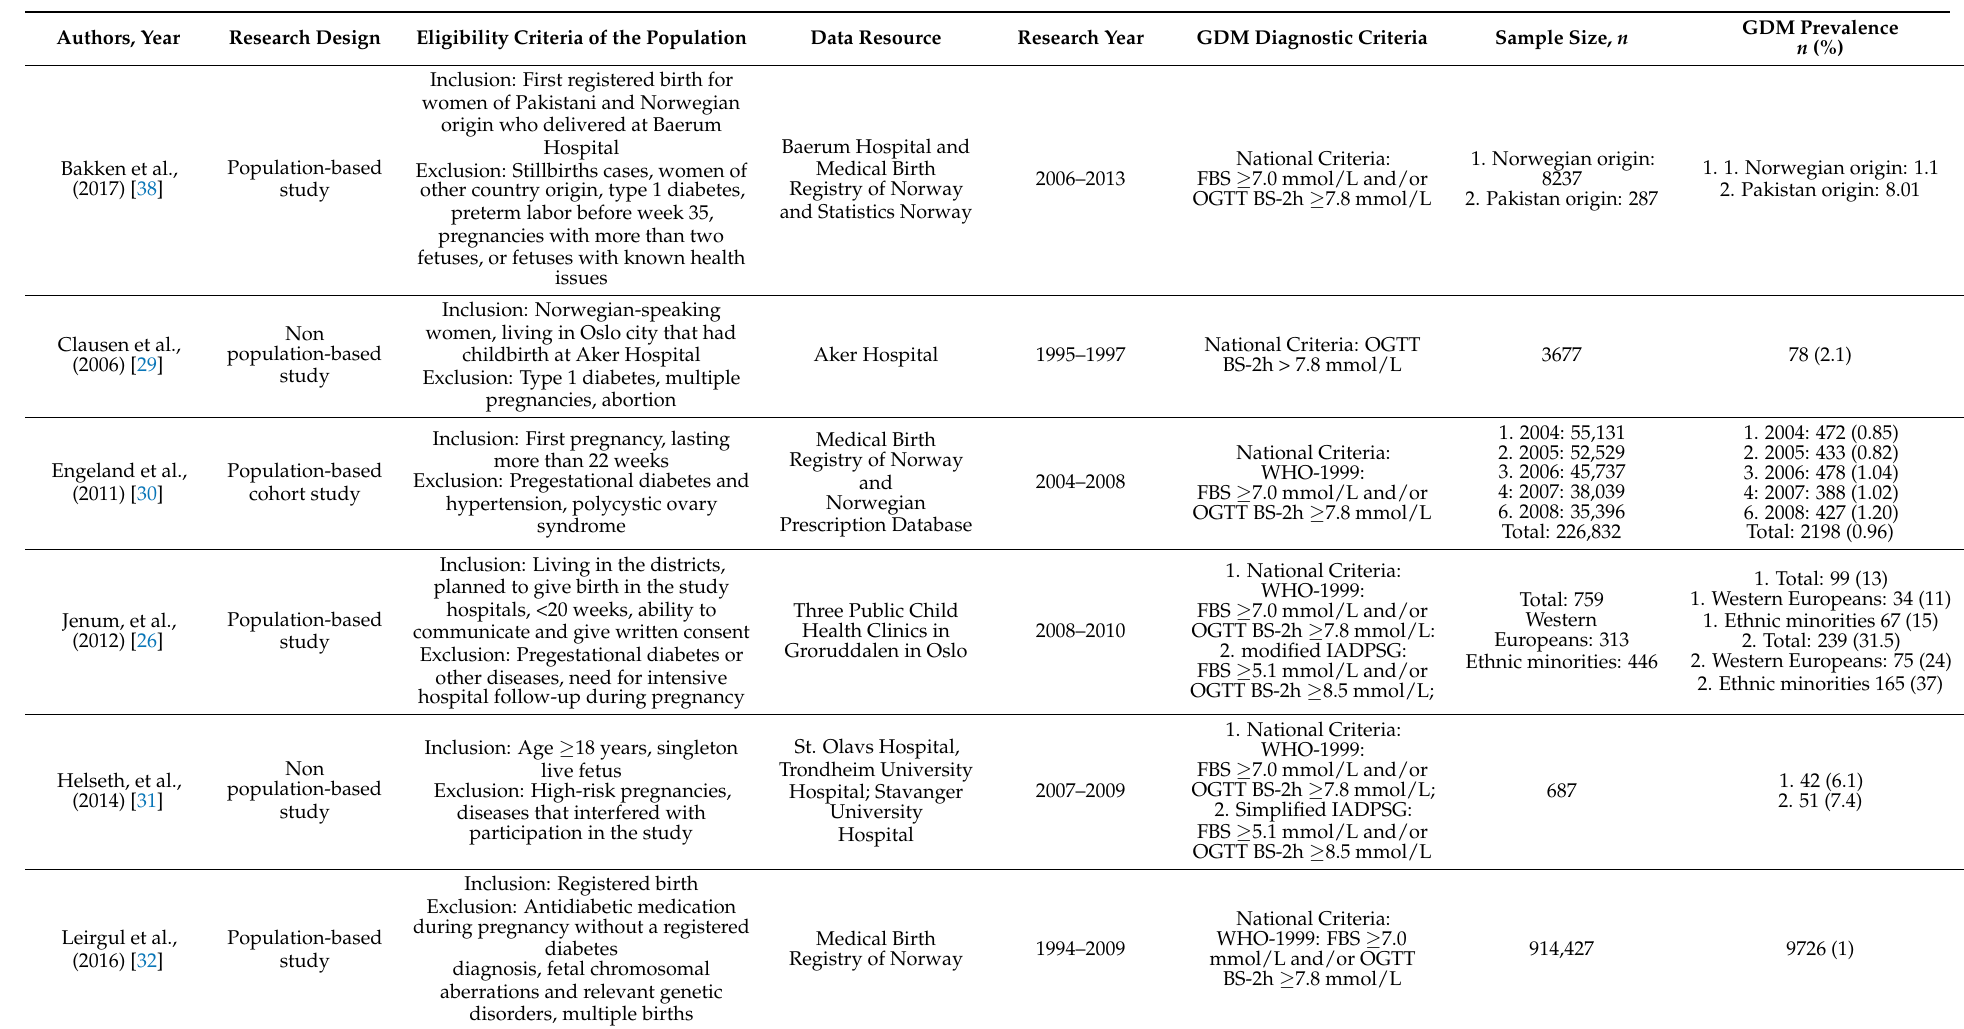
Table 1. The characteristics of the selected studies for data analysis and knowledge